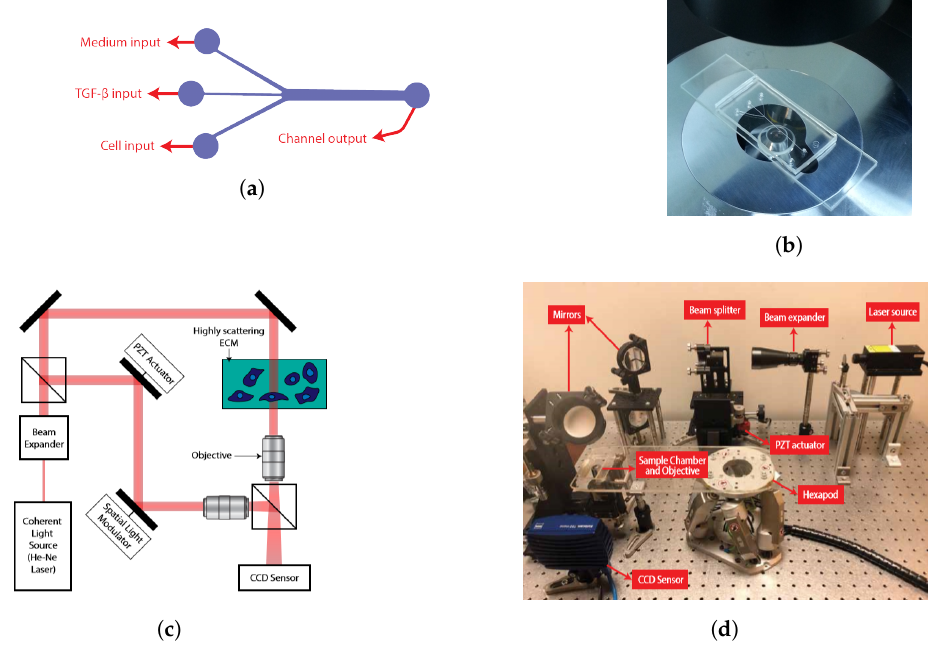
is used to move the observed sample in the lateral axis in order to focus on different cells during a single